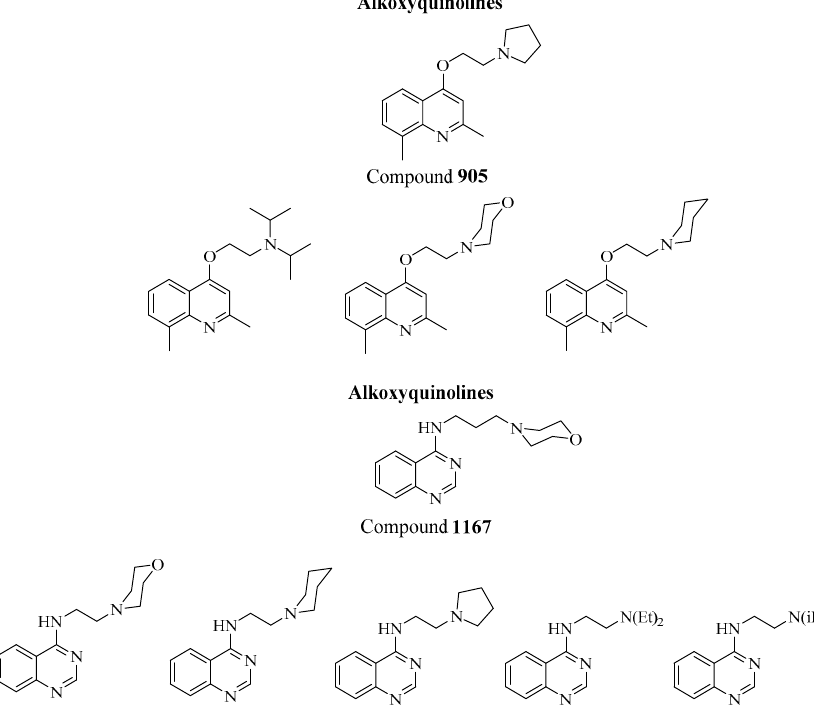
Figure 5. Chemical structures of some of the efflux pump-inhibitors (EPIs) investigated for potential use against K. pneumoniae.